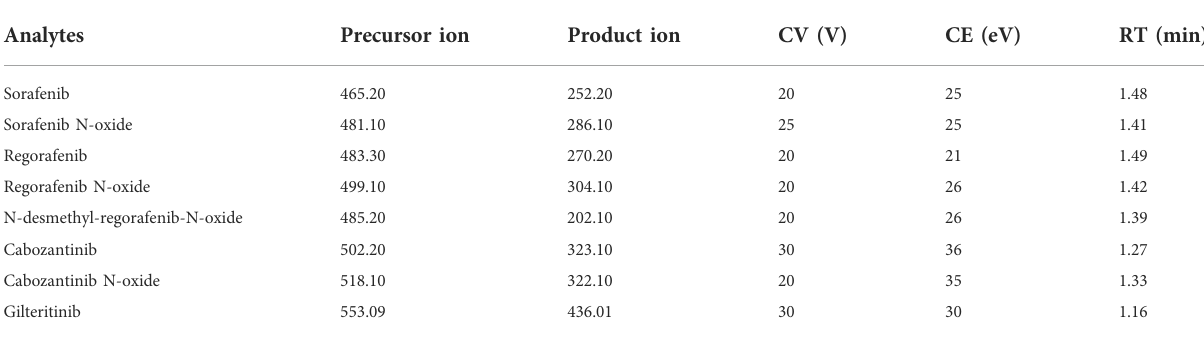
TABLE 1 Speci fi c mass spectrometric parameters and retention times (RTs) for the analytes and IS, including cone voltage (CV) and collision energy